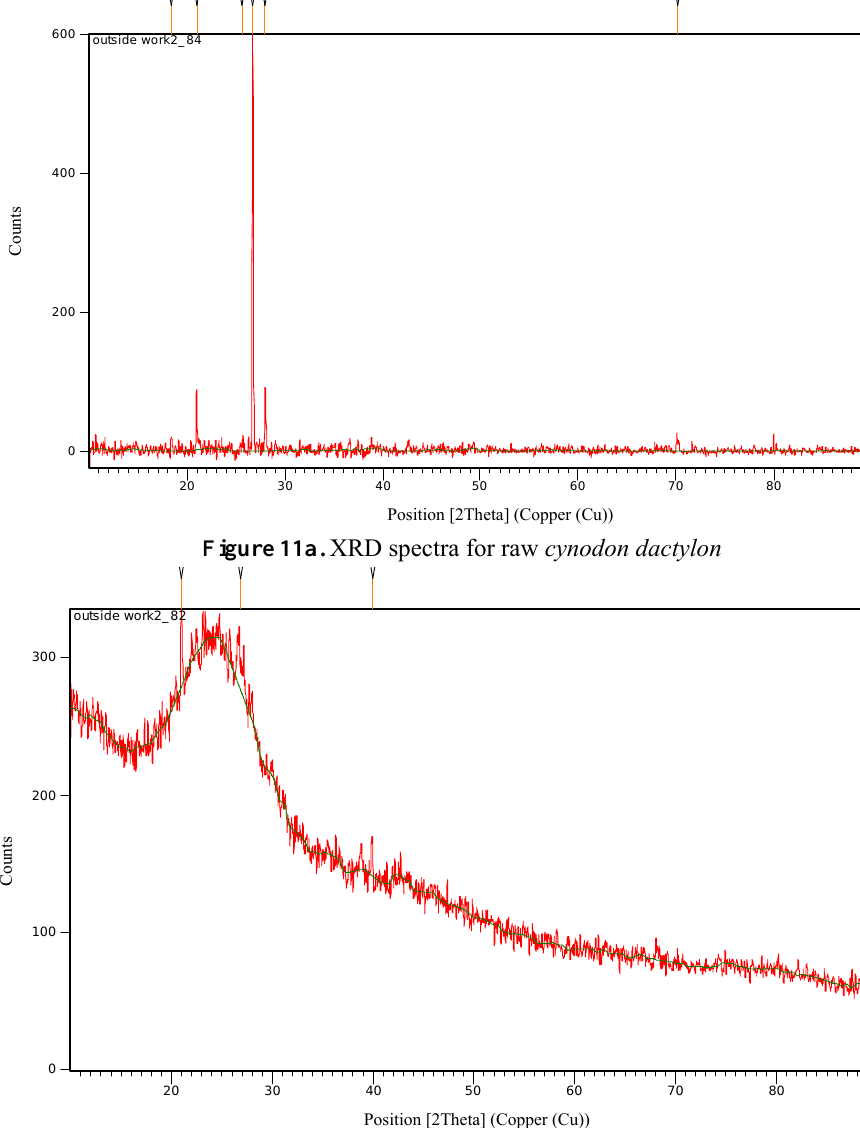
Figure 11a. XRD spectra for raw cynodon dactylon